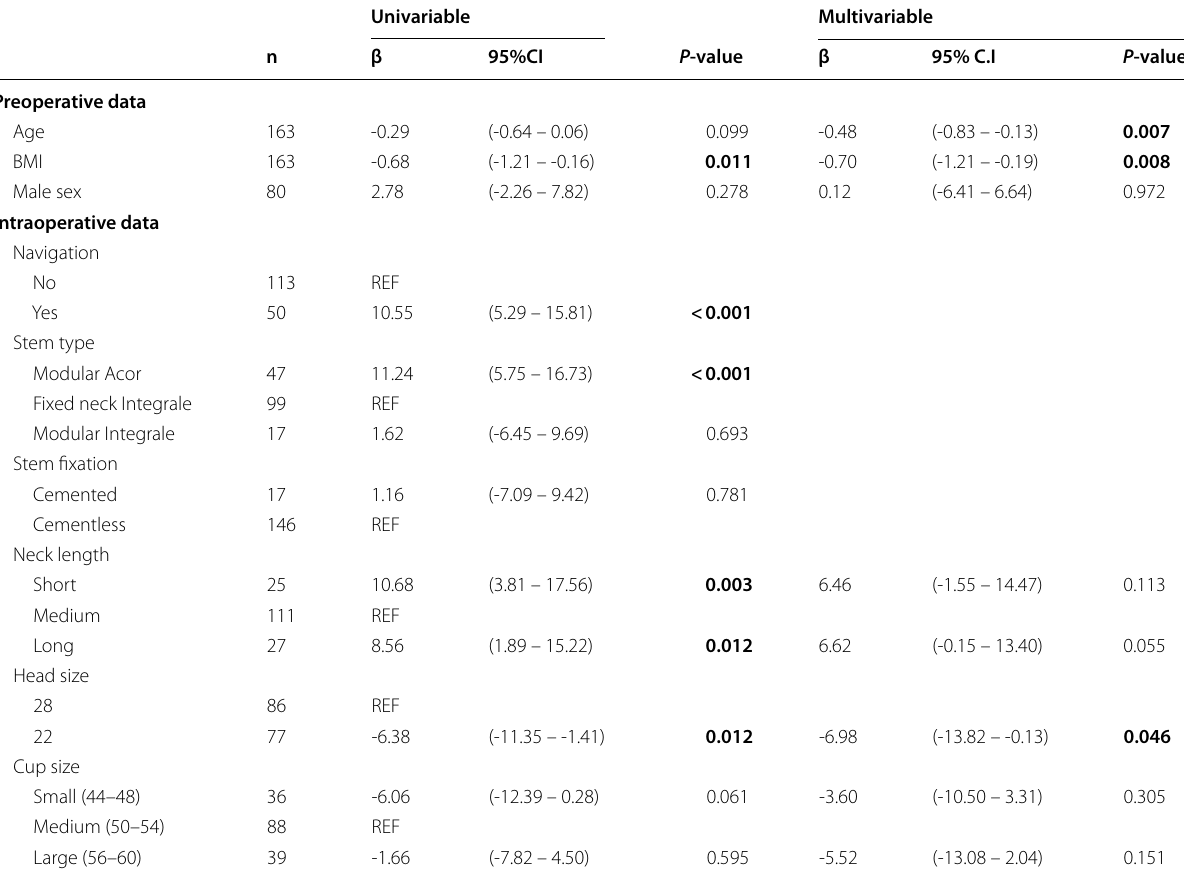
Table 3 Uni‑ and multi‑variable regression analyses of postoperative modified Harris hip score